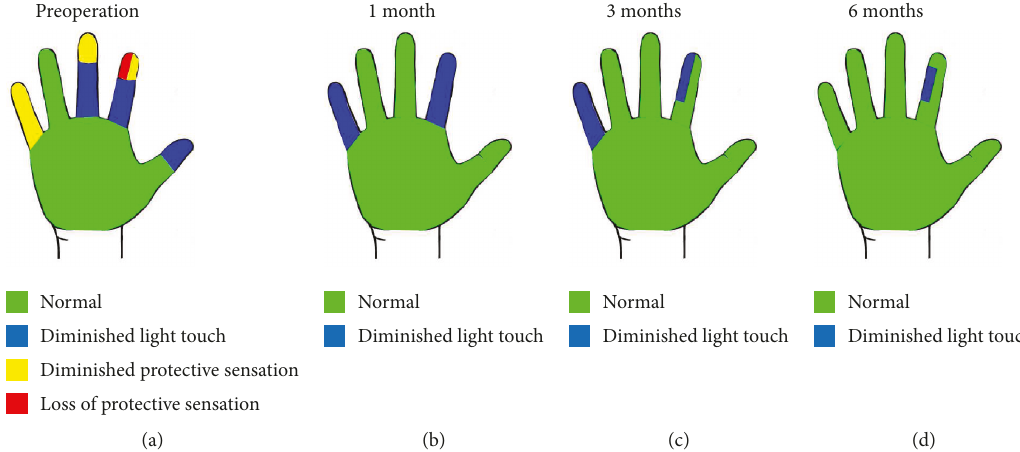
Figure 2: Postoperative course of Semmes-Weinstein mono fi lament test. (a) Preoperative period. Ulnar side of the apex of the index fi nger had no sensation. (b) 1 month after surgery. Sensory disturbance recovered. (c) 3 months after surgery. (d) 6 months after surgery. The entire area with the exception of the injured site appeared